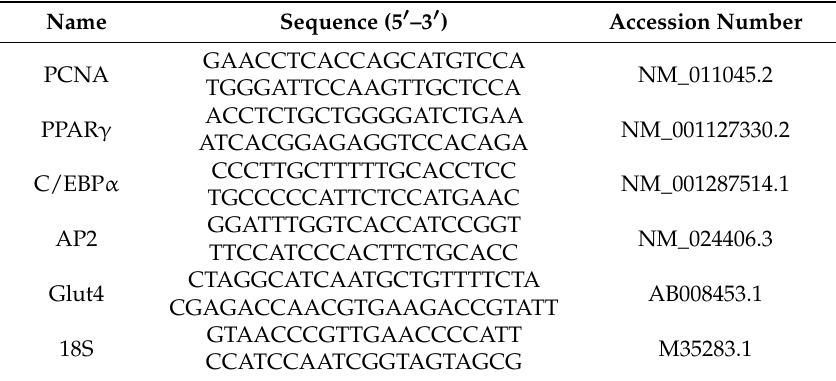
Table 1. Primer sequences for real-time